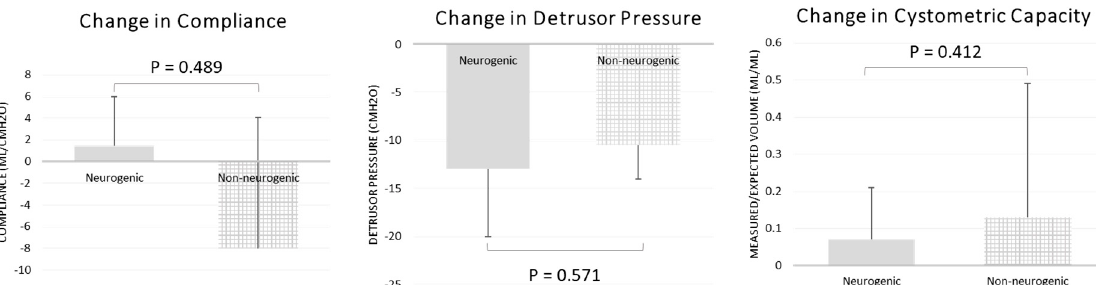
Figure 1. Change in bladder compliance, detrusor pressure, and cystometric capacity, comparing neurogenic OAB group with non-neurogenic OAB group after BoNT-A injection. There was no significant improvement in bladder compliance, detrusor pressure, or cystometric capacity between groups.